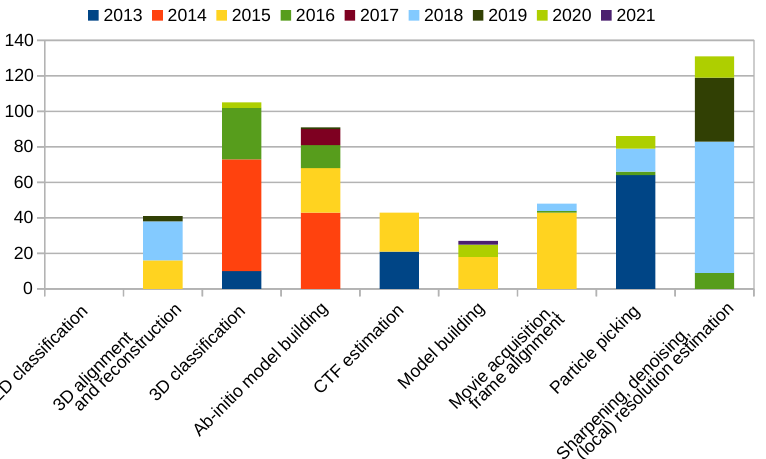
Figure 5. Citations of Xmipp related publications by